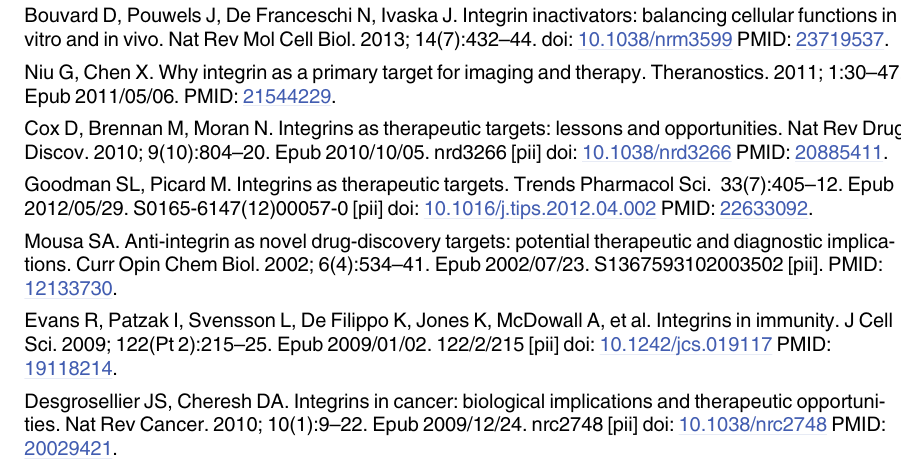
S1 Fig. Colocalization of GFP-kindlin-2 and kindlin-2. S2 Fig. Toxicity of BJINT derivatives: Analyses of 3 representative molecules. S3 Fig. BJINT006 cell adhesion inhibition is not specific to an ECM substrate. S4 Fig. Synthesis strategy for BJINT010-BJINT019. and β integrin tails onto talin F2/F3 domain and kindlin-2 FERM S5 Fig. Binding of β 1 3 domain. S6 Fig. RMN signal shifts with β 3 cytoplasmic tail in the presence or absence of BJINT